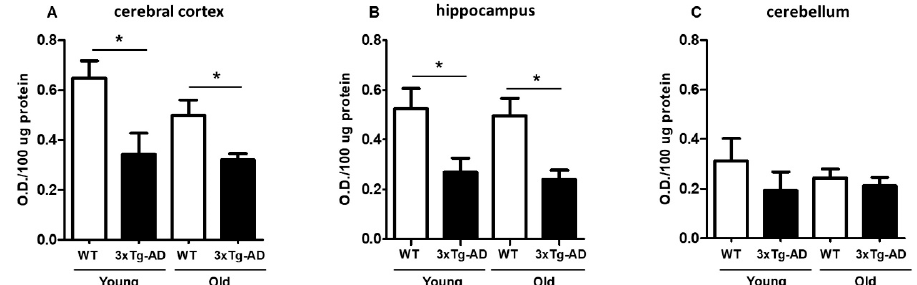
Figure 1. Mitochondrial redox capacity of synaptosomes. Synaptosomes were isolated from young and middle-aged female wild-type (WT) and 3xTg-AD mice and were assessed by MTT reduction after a 90 min incubation. Cortical synaptosomes ( A ), hippocampal synaptosomes ( B ) and cerebellar synaptosomes ( C ) are shown. Data are expressed as the mean percentage ± SEM of duplicates from 3–4 different individual animals per group. Student’s t test * p < 0.05.